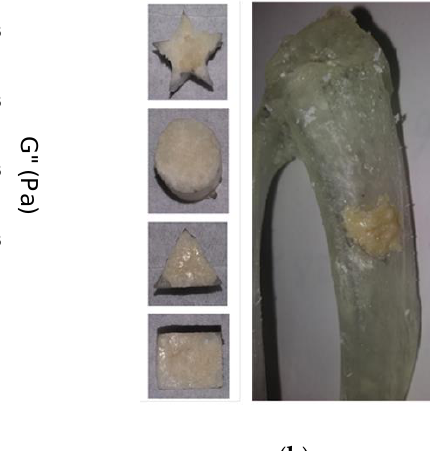
Figure 1. ( a ) SEM image of ABVF after manufacturing. The outer surface is rough (top left corner) and the inner surface has pores (top right corner). SEM images of ABVF degradation in phosphate buffered saline at different time points, showing increasing signs of degradation on both the outer and inner surfaces of the ABVF. ( b ) The micro-computed tomography image of ABVF shows a homogenous distribution of the PRO OSTEON particles in the polymer matrix.